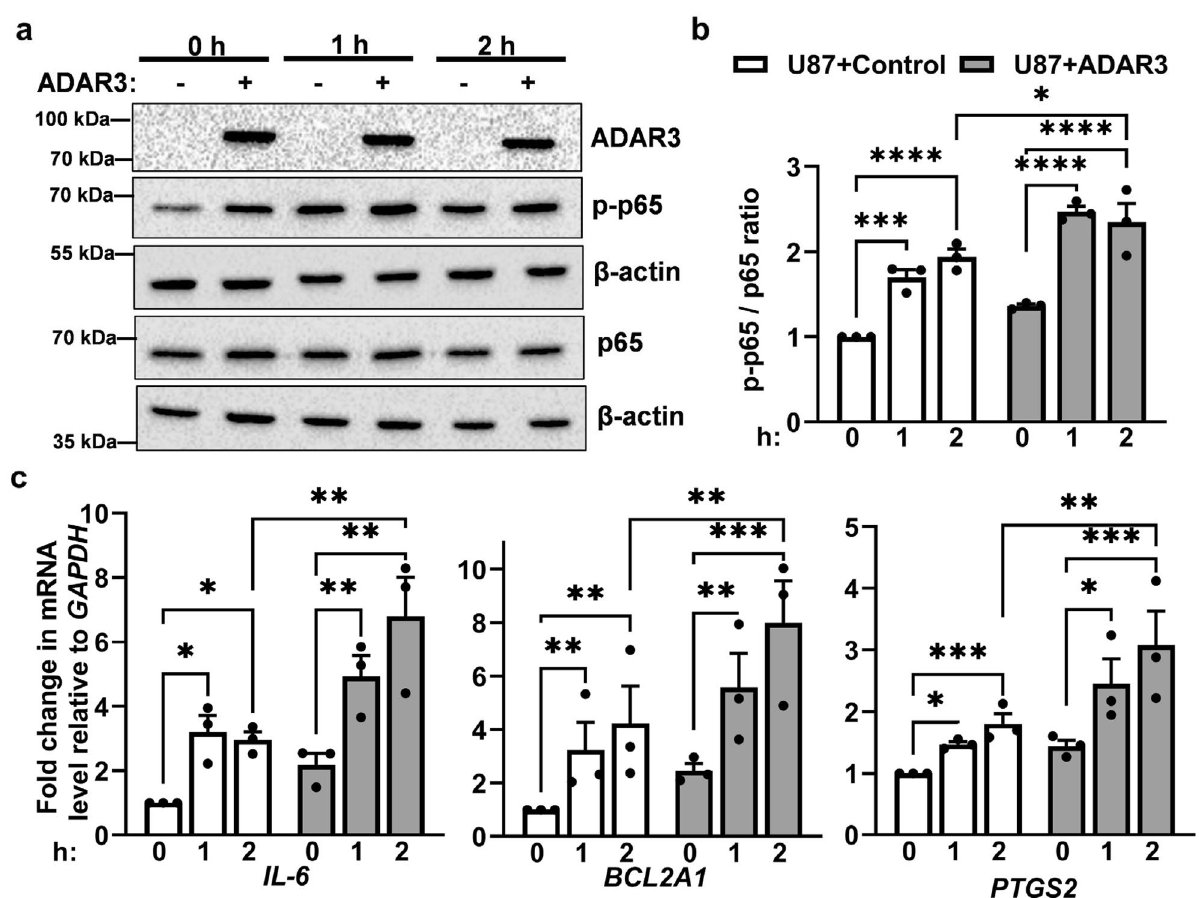
Figure 4. Increased TNF-α induced NF-κB activation in ADAR3-expressing cells. ( a ) Control and ADAR3- expressing U87 cells were treated with 10 ng/mL TNF-α for 0, 1, and 2 h. Equivalent amounts of cell lysate were subjected to immunoblotting with the indicated antibodies. Blot is a representative image (replicate 1) of three biological replicates and uncropped images are included in the supplementary information file ( b ) Quantification of phosphorylated p65 protein (p-p65) to total p65 protein levels was determined relative to β-actin controls for each immunoblot. The relative p-p65/p65 ratios were normalized to the U87 control cells at 0 h. Error bars represent SEM. Statistical significance was determined by two-way ANOVA Fisher’s least significance difference (LSD) test. *p ≤ 0.05, **p ≤ 0.005 ***p ≤ 0.0005, ****p < 0.0001 ( c ) qRT-PCR was performed to quantify the expression of the indicated genes after 0, 1 and 2 h TNF-α treatment. The expression of each gene relative to GAPDH in all conditions was normalized to the expression of same gene relative to GAPDH in control cells at 0 h. The mean of three biological replicates is plotted with error bars representing SEM. Statistical significance was determined using ordinary two-way ANOVA Fisher’s LSD test. *p ≤